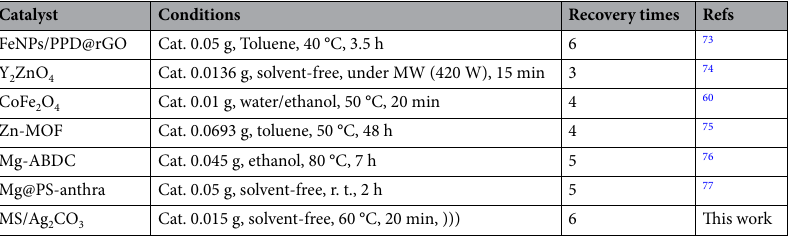
Table 3. Comparison of the catalytic activity of MS/Ag 2 CO 3 with other catalysts. PPD p-phenylenediamine, rGO reduced graphene oxide, MOF metal–organic framework, ABDC 2-aminobenzene-1,4-dicarboxylate anion, PS polystyrene, anthra anthranilic